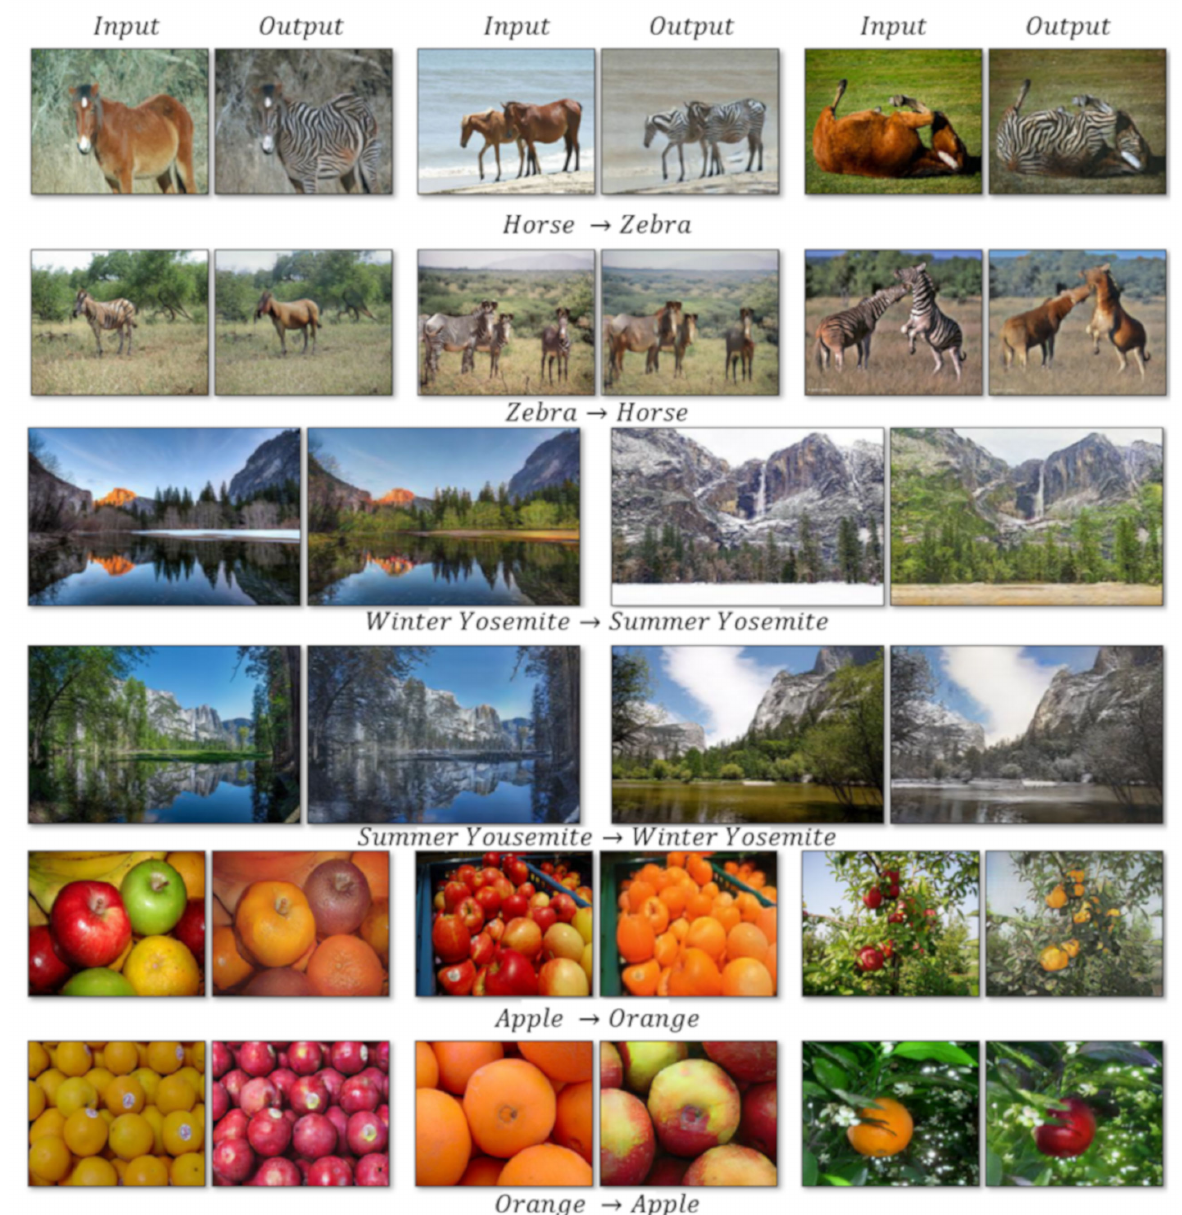
Figure 22. Example of image translation in CycleGAN (Cycle-consistency Generative Adversarial Networks)